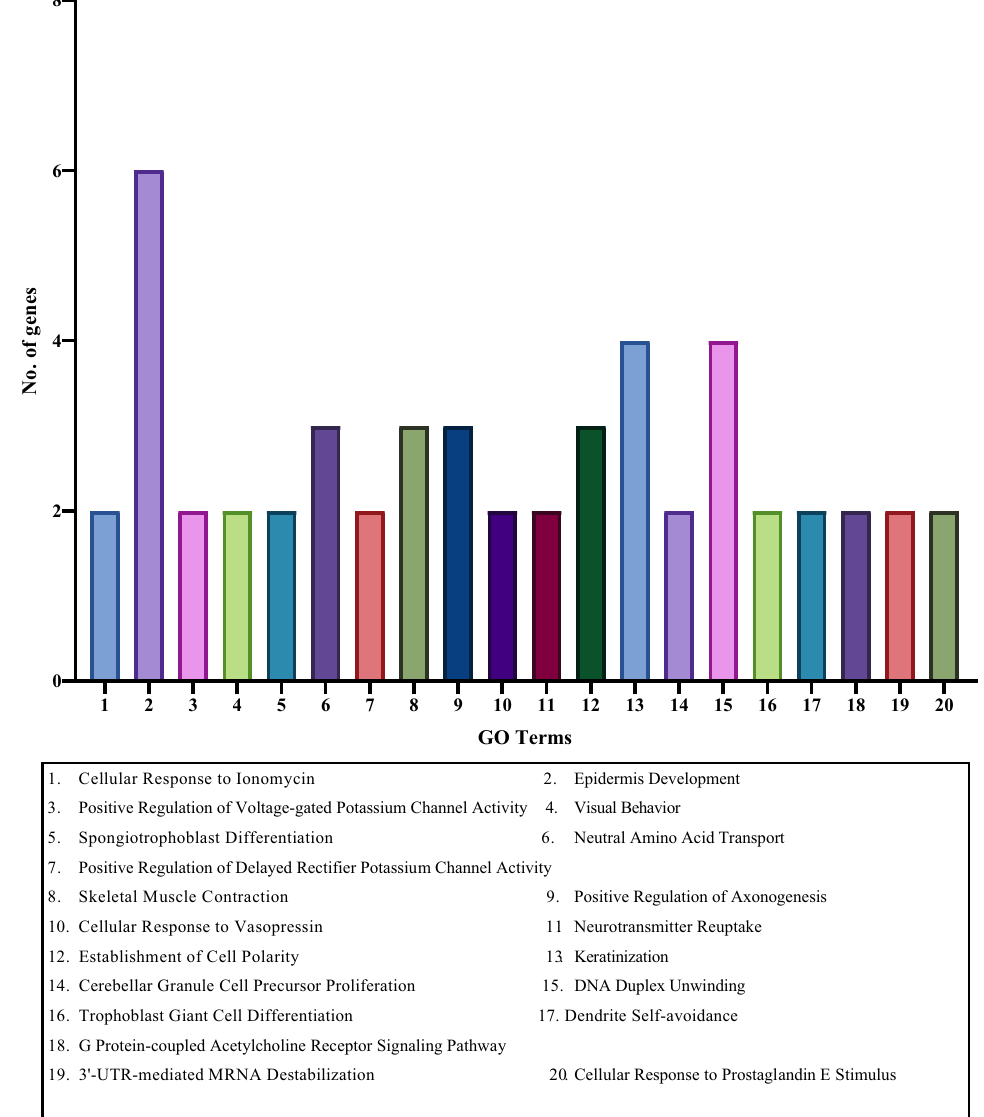
Fig. 7 Biological Process on GO Study (hg-38). The Gene Ontology enrichment analysis of the Mural and Cumulus Granulosa Cells. The number of genes that are more prevalent in each biological process is represented along the vertical axis of the bar